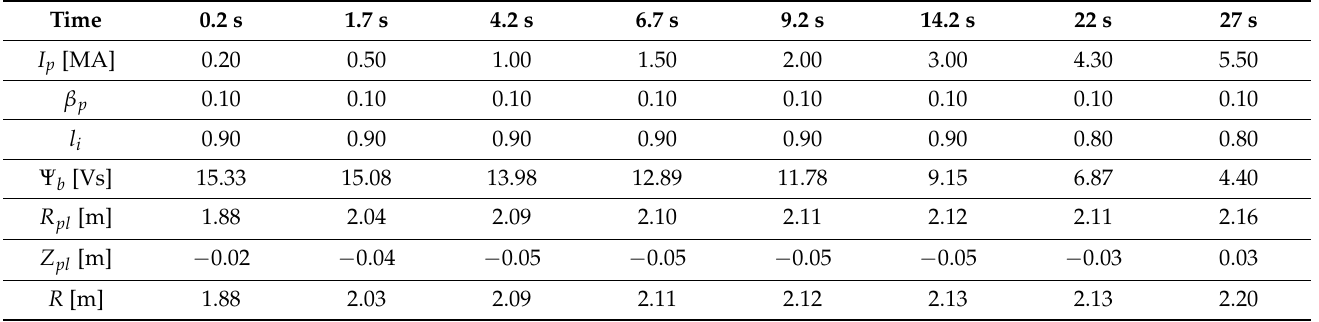
Figure 4. Time evolution of voltages for the DTT ramp-up phase: ( a ) CS voltages; ( b ) PF voltages. Table 4. Time evolution of main plasma parameters of the SN ramp-up phase with a plasma current Table 3. Time evolution of CS/PF currents of the SN ramp-up phase with a plasma current rate of 200 kA/s.